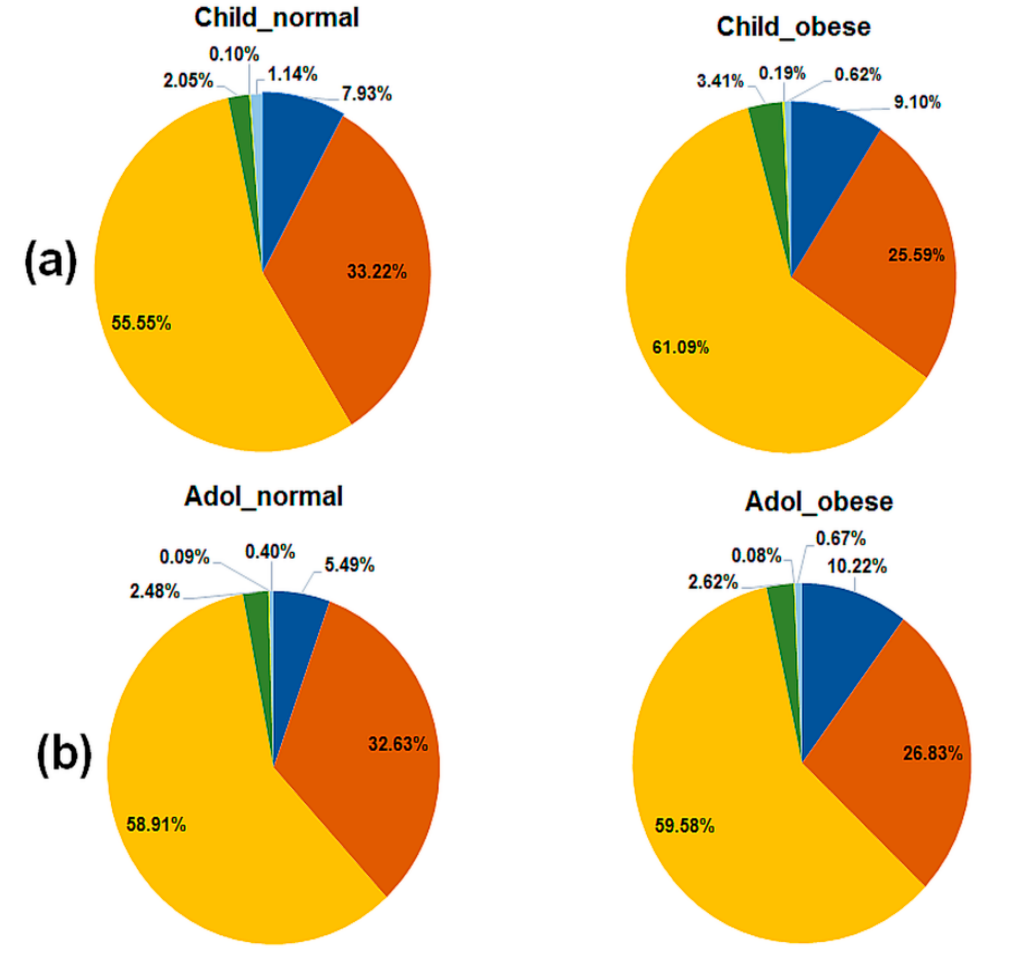
Figure 2. Relative abundance of gut bacterial phyla in children ( a ) and adolescents ( b ). Pie charts shows the gut microbial diversity for each phenotypic group which is indicated on top. The relative abundance of each phylum is shown as percentage (%) beside the charts. Actinobacteria, Bacteroidetes, Firmicutes, Proteobacteria, Tenericutes, and “Others” phyla are indicated by the different colors, described at the bottom of the figure. Tags on top of each chart are normal weight children, obese children, normal weight adolescents and obese adolescents. Additional information is in Table S3.